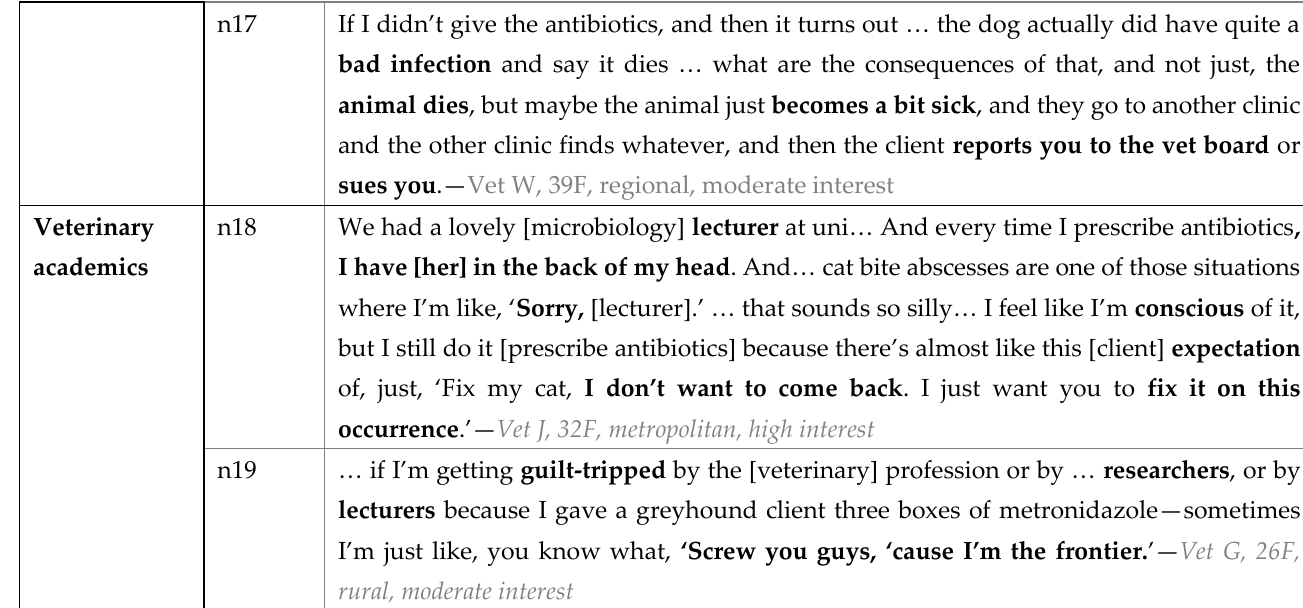
Figure 6. Normative beliefs influencing decision to withhold or delay antimicrobial treatment where there is no clear indication, and illustrative quotes. Bold text has been used to highlight key ideas. Grey italics have been used for participant code, age and gender, location of practice and level of interest in AMR and AMS. As previously discussed, multiple interviewees mentioned that their clients commonly communicated an expectation of receiving antimicrobials for their animal, which made it more difficult to withhold them. Such expectations were often established by other veterinarians who had previously prescribed antimicrobials (n1, n12), especially for the same clinical presentation (n2, n3). In this situation, withholding antimicrobials could be seen as directly contradicting the previous veterinarian(s), which led to psychological discomfort, particularly when the previous veterinarian was more experienced (n2). Veterinarians in the UK also cited this awkwardness as a driver of antimicrobial prescribing [18]. In human hospitals, a similar unwillingness to break professional etiquette by questioning the decisions of others, particularly others of higher status, also enables inappropriate antimicrobial prescribing